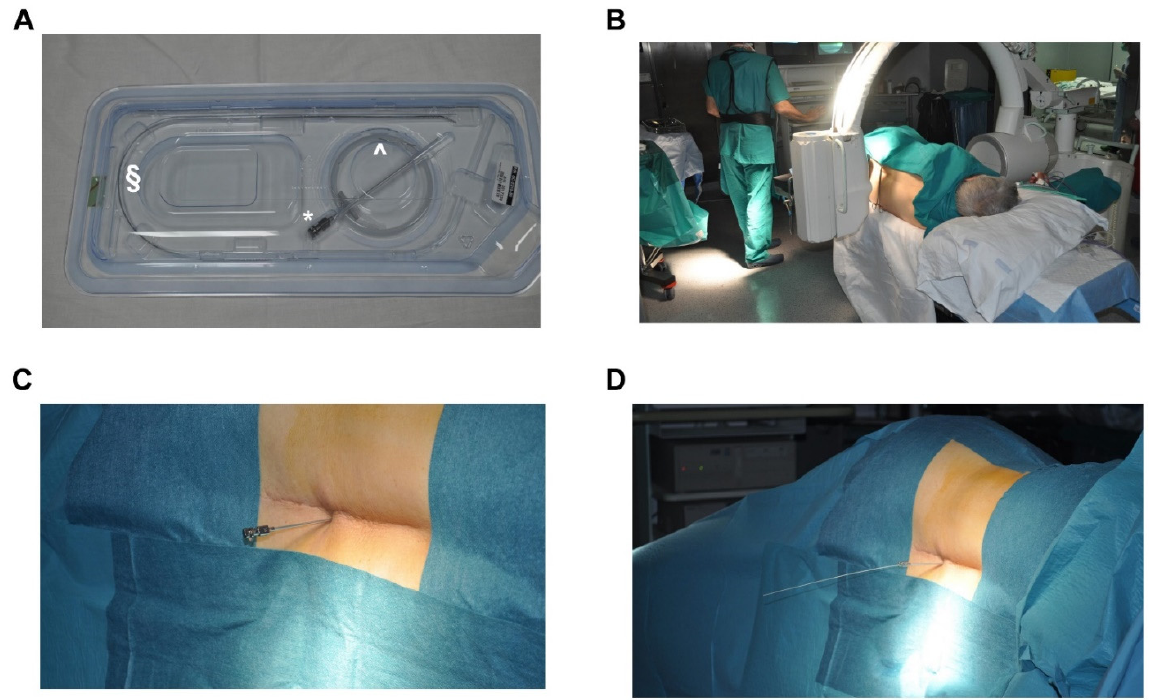
Figure 1. Technical features for electrode implantation.